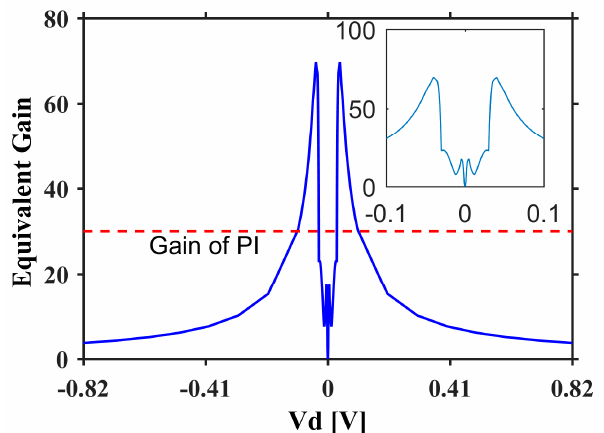
Figure 10. Equivalent gain for desired inductor current with input V d at an OCV of 3.3 V.